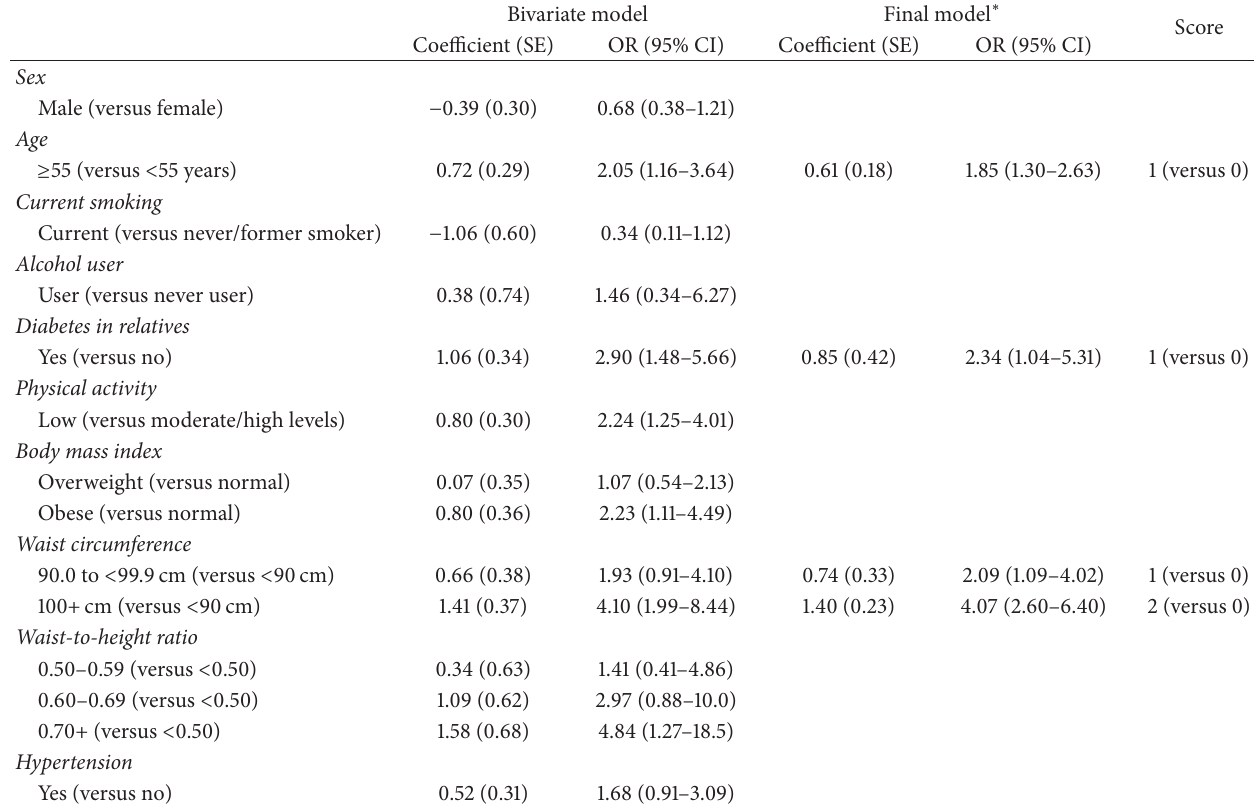
Table 2: Risk factors and beta coefficients for undiagnosed diabetes: final regression model using CENAN database ( 𝑛 =